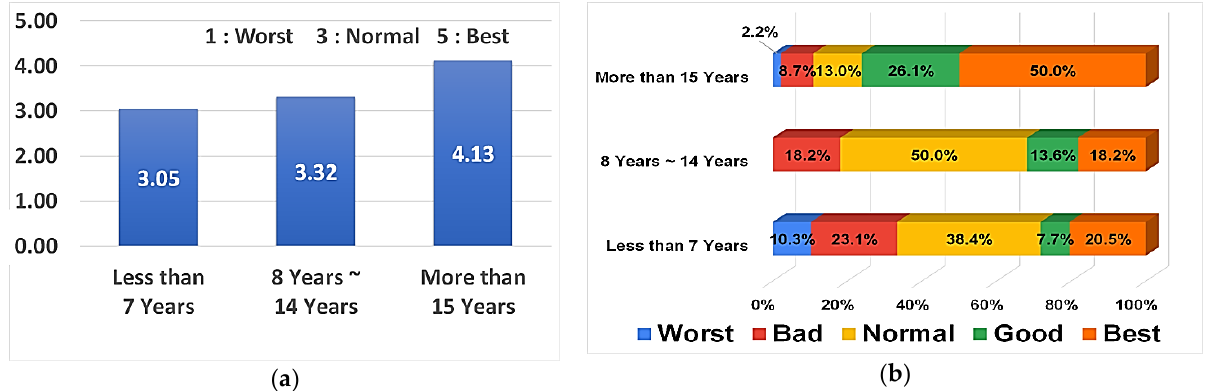
Figure A8. ( a ) Users’ understanding of the term ‘MARK’ by experience of GPS plotter usage. Average (1: Worst to 5: Best); ( b ) distribution of respondents (percentage).